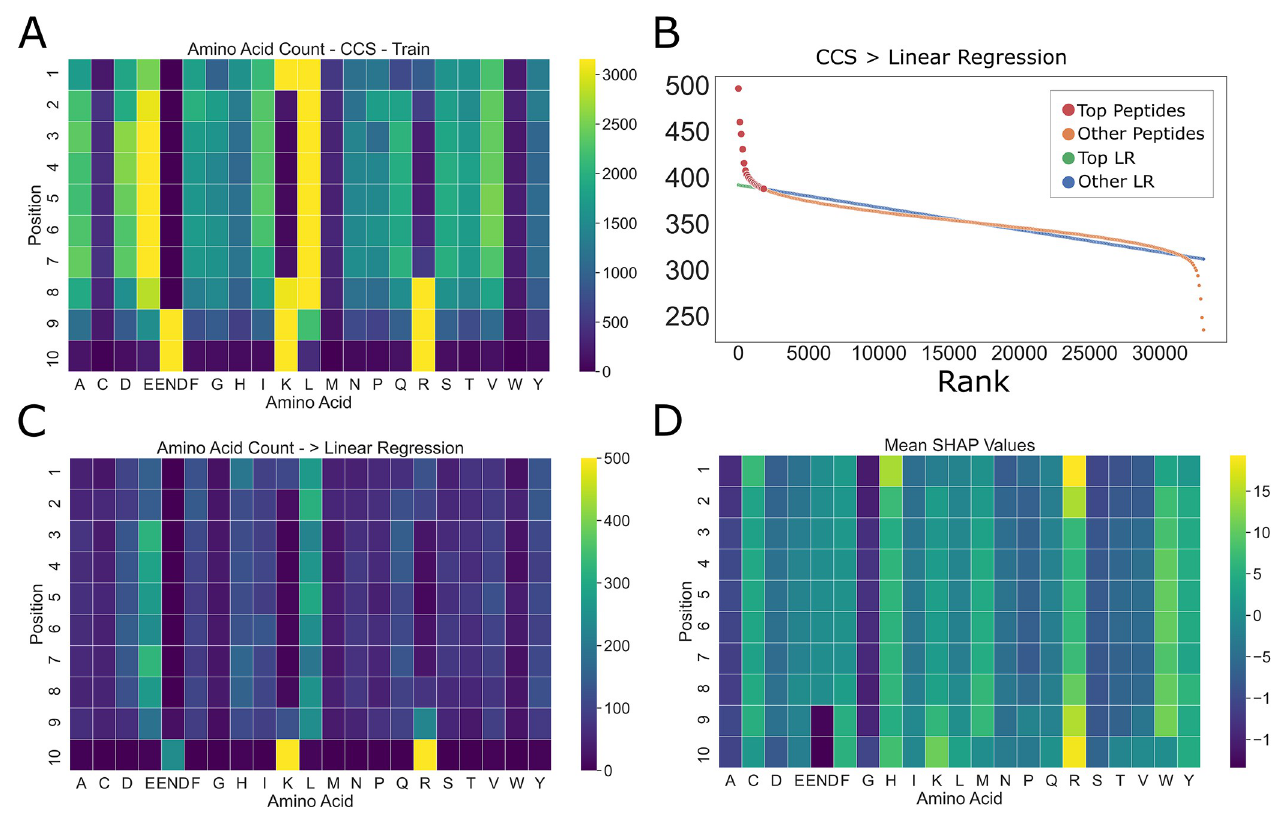
Fig 5. Amino acid summary statistics differ from PoSHAP values for the CCS data. (A) Amino acid counts as a function of position for training data. (B) Procedure for picking the ‘top peptides’ with the highest CCS. Linear regression was performed on the peptides ranked by their actual CCS value. Any peptide that fell above the trendline and overall mean were defined as ‘top peptides’. (C) Counts of amino acids for the top peptides were summarized in a heatmap. (D) Mean SHAP values across amino acids and positions from PoSHAP analysis.